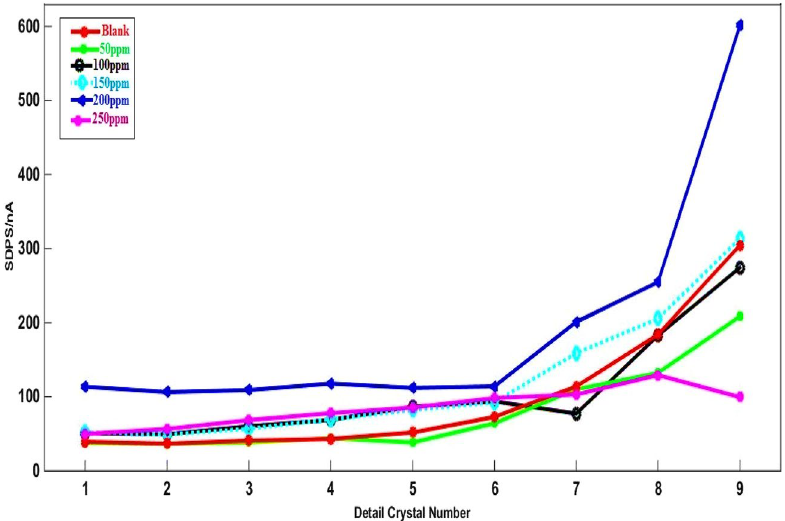
Figure 9. SDPS plots of Sy-Co in absent and presence of varies concentrations of RA/Ag NPs.